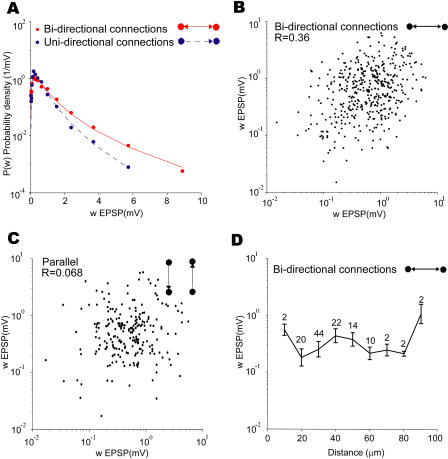
Bidirectionally Connected Pairs Contain Connections That Are Stronger and Correlated(A) Synaptic connections in bidirectionally connected pairs are on average stronger than those in unidirectionally connected pairs. The probability density distribution for both the reciprocal (red solid, p(w) = 0.41exp(−(ln w + 0.60)2/(2 × 0.9762)/w) and nonreciprocal (blue dashed, p(w) = 0.47exp(−(ln w + 0.81)2/(2 × 0.8342)/w) connections are shown.(B) In bidirectionally connected pairs synaptic connection strengths are moderately but significantly correlated (R = 0.36, p < 0.0001).(C) Scatter plot of the strength of synaptic connections that shared no pre- and postsynaptic neurons in the same quadruple recording. There might be other connections in the quadruplet besides these two connections. No significant correlation is observed (R = 0.068, p = 0.48). All correlations calculated using Pearson's R method in log space.(D) Average connection strength for bidirectional connections does not vary systemically with interneuron distance (one-way ANOVA, p = 0.068). Numbers on top of data points are the number of connections. Error bars are standard errors of the mean.